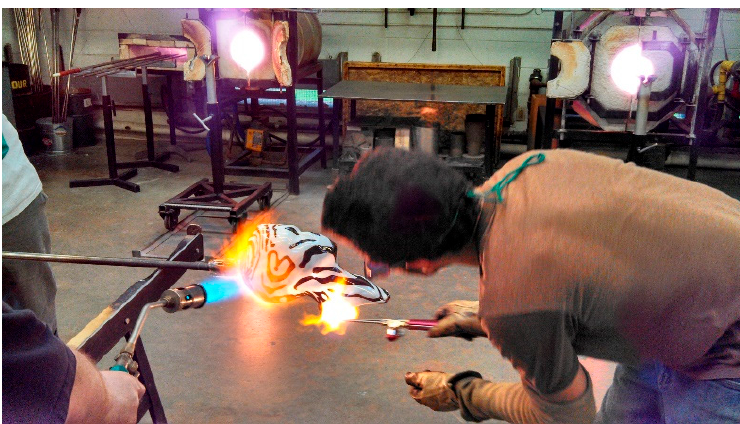
Figure 8. Torching the bubble prior to sculpting details and features. [Created by author].